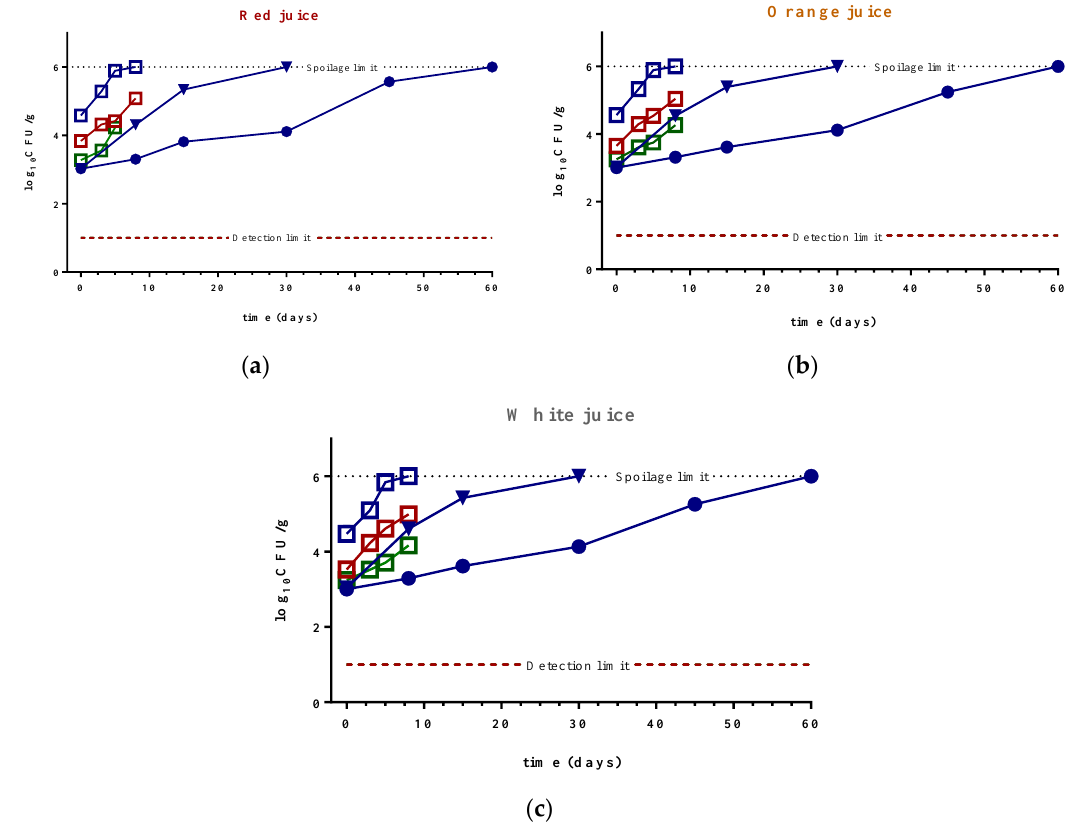
Figure 1. Evaluation of the total aerobic psychrophiles (blue), Enterobacteriaceae (red) and yeast and mold (green) counts (expressed in Log10 CFU/mL) in juices of O. ficus-indica cultivars: ( a ) ‘Rossa’ (red juice); ( b ) ‘Gialla’ (orange juice); and ( c ) ‘Bianca’ (white juice) (non-pasteurized —□, pasteurized with pressure —●, pasteurized with temperature— ▼ , unfit for consumption (6.0 log) — •••• , and below the detection limit — ----). Samples of Enterobacteriaceae and yeasts and molds for both HP and thermal pasteurization were below the detection limit (1.0 log) and are not represented in the graph. Results are expressed as averages ± SD.